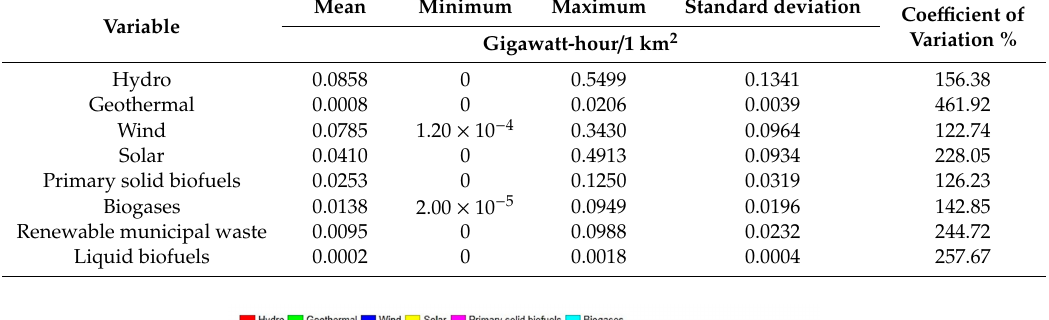
Table 8. Basic statistical parameters of variables determining the volume of energy production from renewable energy sources in the EU countries in 2017 per 1 km 2 (own study).